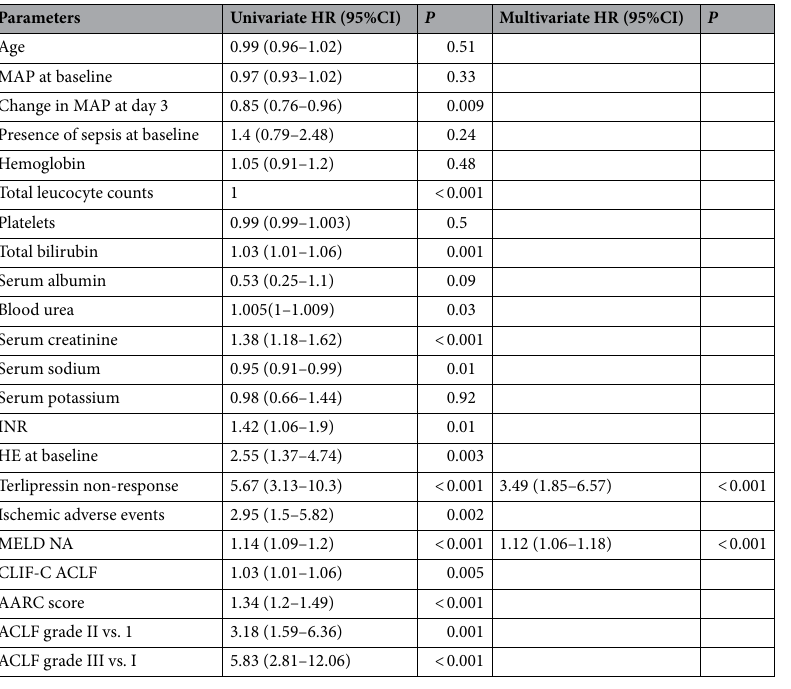
Table 5. Predictors of mortality on univariate and multivariate stepwise cox regression analysis. HR hazard ratio, EASL European association for the study of the liver, ACLF acute-on-chronic liver failure, MAP mean arterial pressure, INR international normalized ratio, HE hepatic encephalopathy, MELD NA model for end- stage liver disease sodium, CLIF-C ACLF Chronic Liver Failure Consortium acute-on-chronic liver failure score, AARC APASL ACLF research consortium. *Change in MAP at day 3, ACLF grade, terlipressin non- response, Creatinine, TLC, HE, blood urea, sodium, Total bilirubin, Albumin, AARC score, CLIF-C score, MELD NA